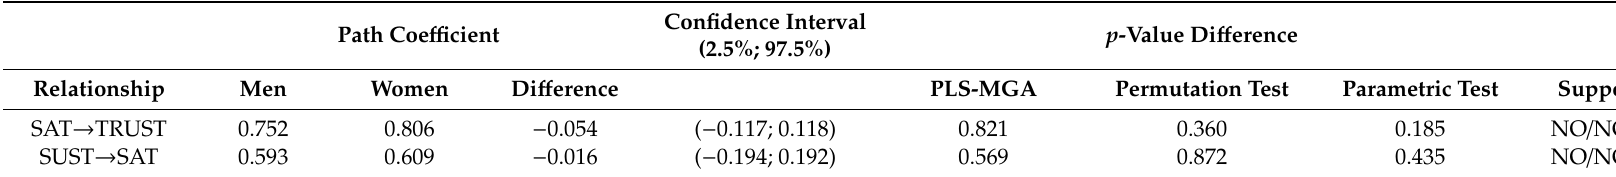
Table 7. Result for Hypothesis